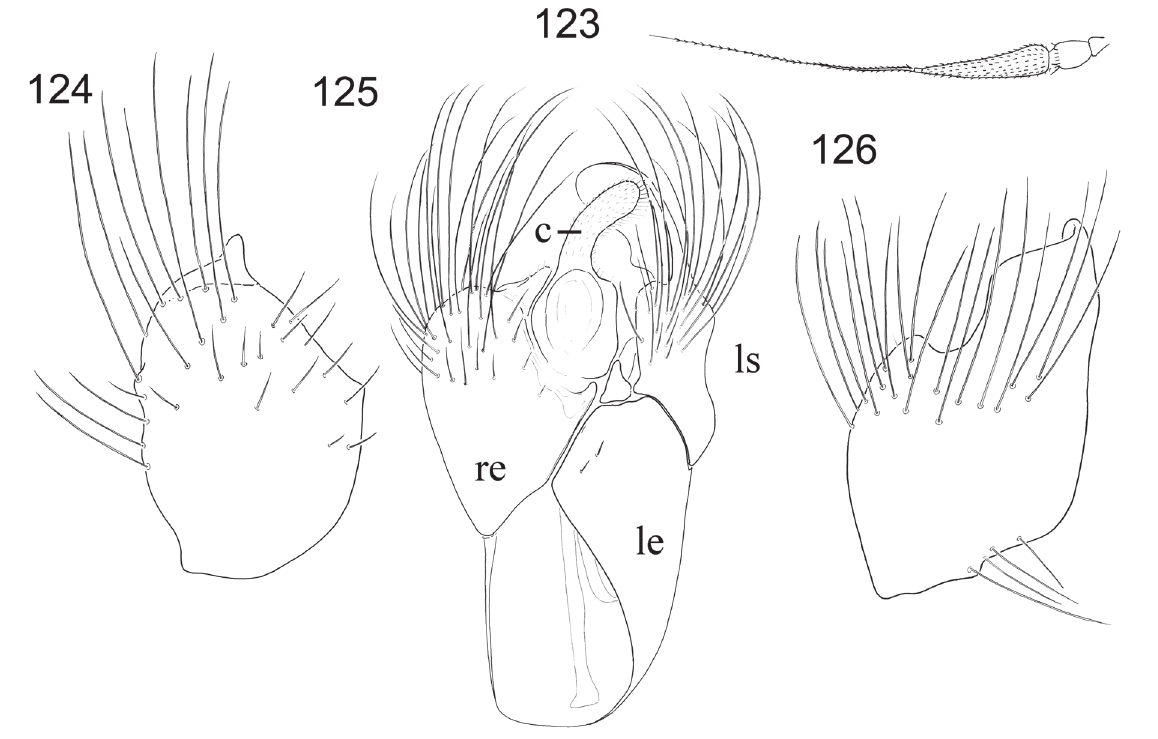
Figs 123-126. Elaphropeza limosa Shamshev & Grootaert, 2007, ♂. 123 . antenna, lateral view. 124 . right epandrial lamella, lateral view, 125 . epandrium and cerci, dorsal view. 126 . left surstylus, lateral view. (after Shamshev & Grootaert